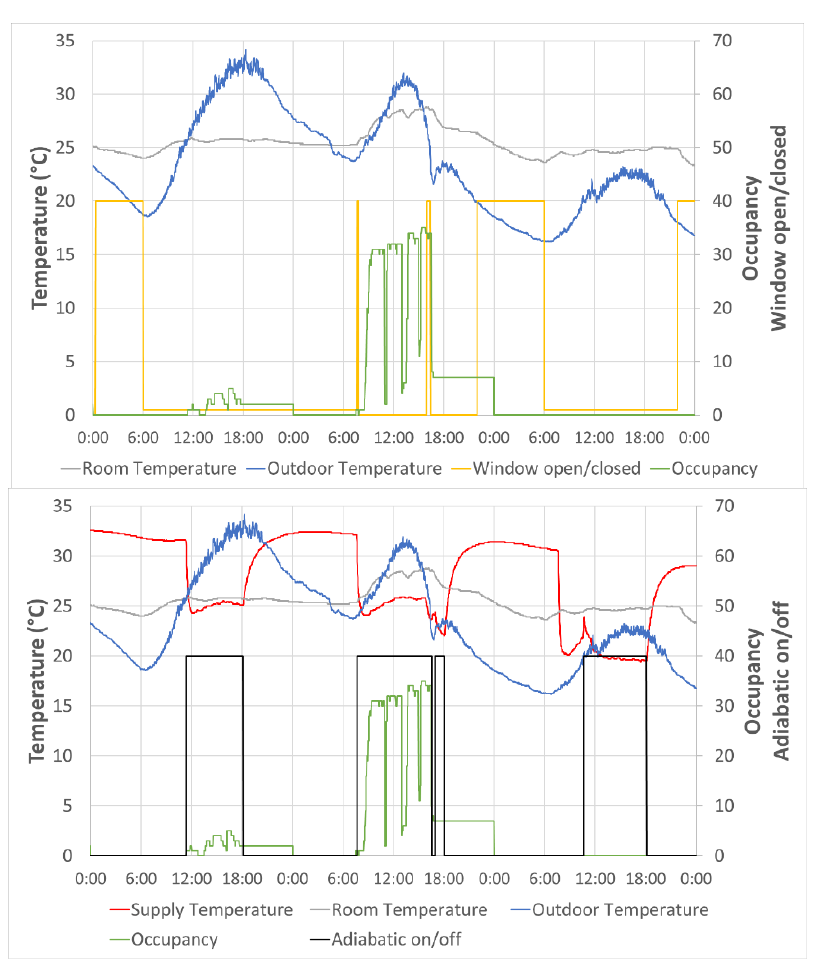
Figure 11. Operation of windows ( above ) and IEC ( below ) during an extremely warm period (21–23 June 2017).